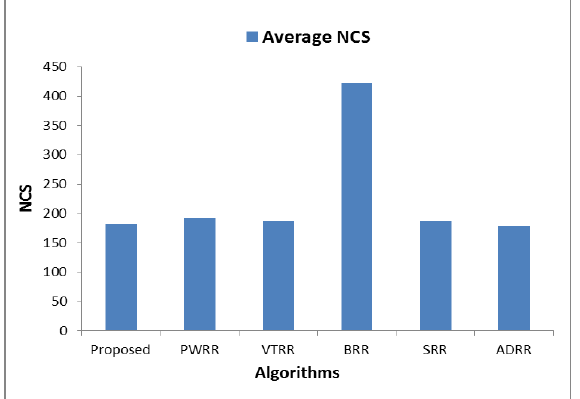
Figure 5. Comparing algorithms’ NCS.